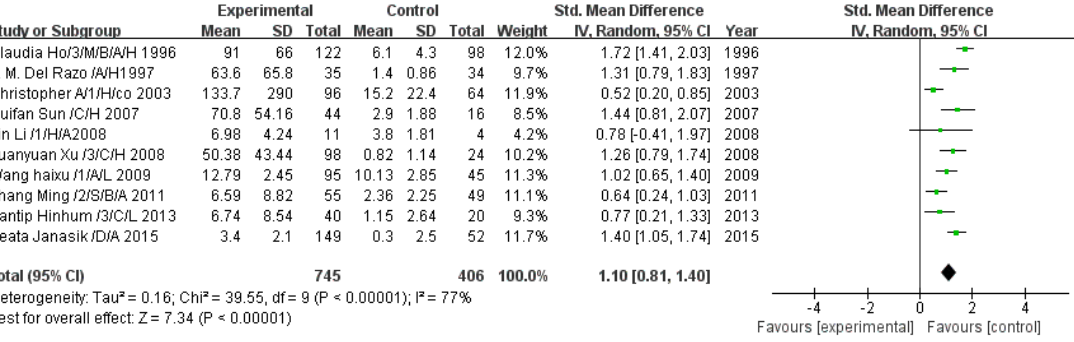
Figure 4. Effect of arsenic exposure on monomethyl arsenic (MMA) concentration in urine. Std., standardized; SD, standard deviation; IV, independent variable; CI, confidence interval.